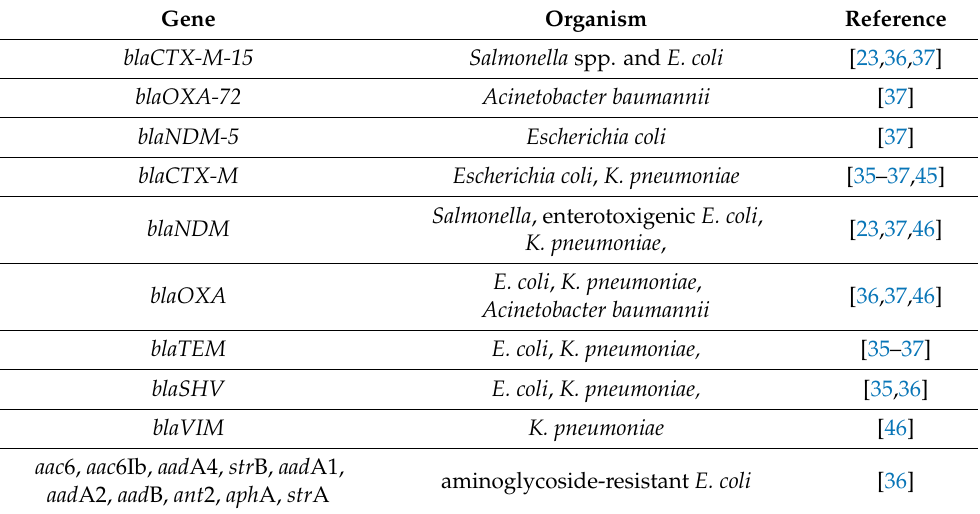
Table 1. A Summary of the different extended-spectrum- β -lactamase ( bla ) genes that had been identified in the